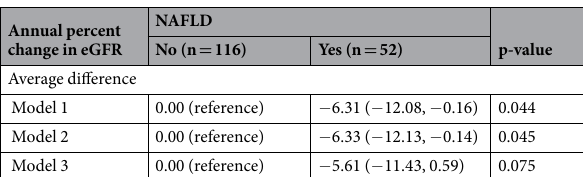
Annual percent change in eGFR